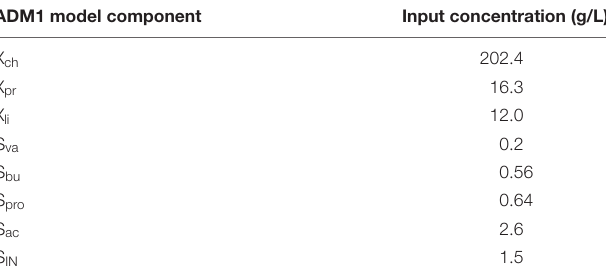
TABLE 4 | Input composition during continuous anaerobic digestion of maize silage, taken from Weinrich and Nelles (2015). ADM1 model